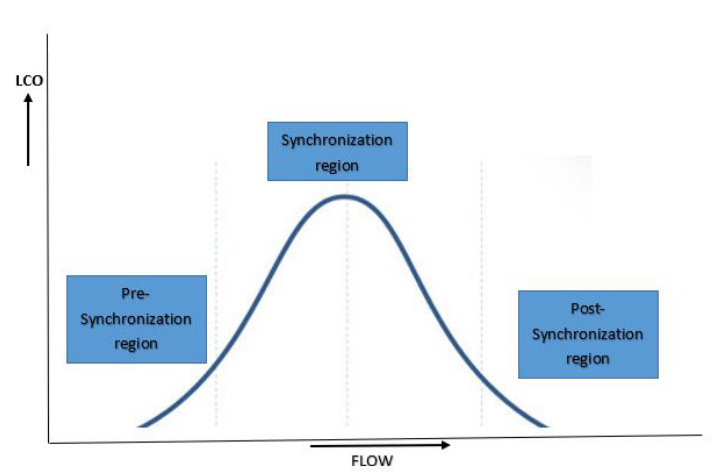
Figure 5. Bifurcation diagram (in dynamical system, this figure is representing data points that have been approched or approximated by a system as a bifurcation parameter in a system revealing bifurcation theory).